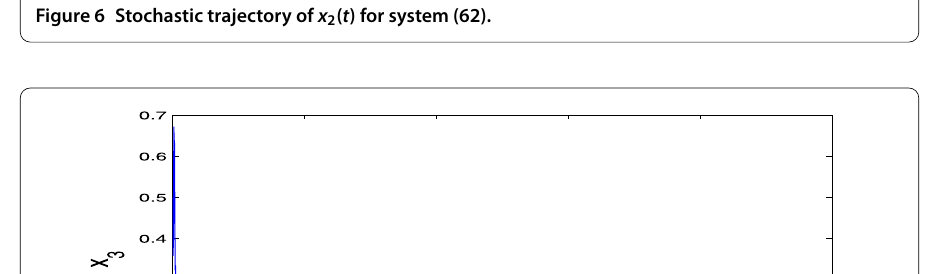
Figure 6 Stochastic trajectory of x 2 ( t ) for system (62).